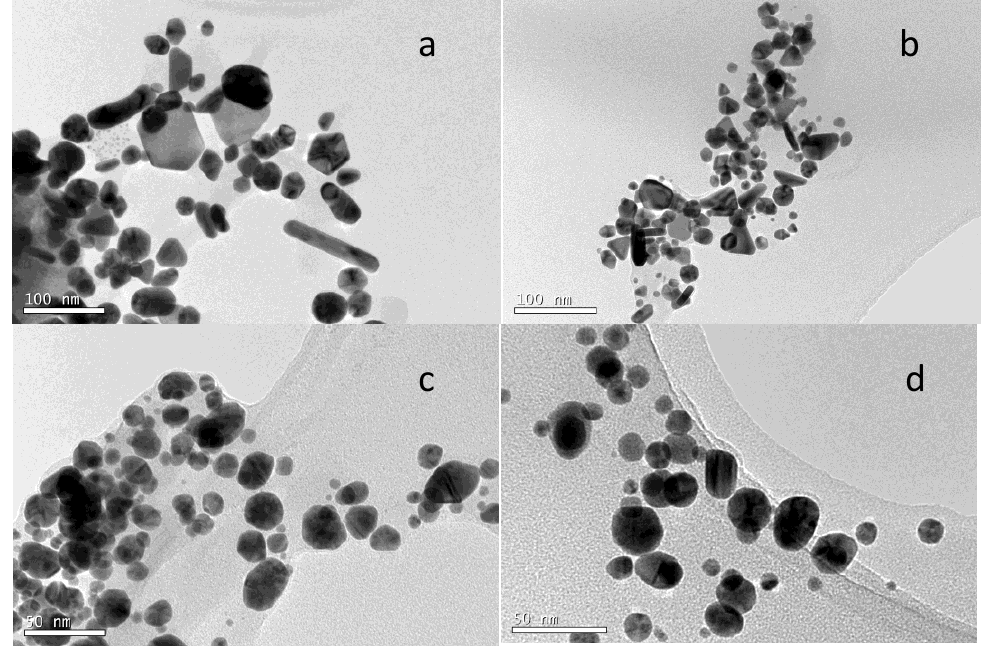
Figure 2. TEM images of gold nanoparticles using 100 mg/L HAuCl 4 prepared at different initial pH values: ( a ) pH 2; ( b ) pH 4; ( c ) pH 7; and ( d ) pH